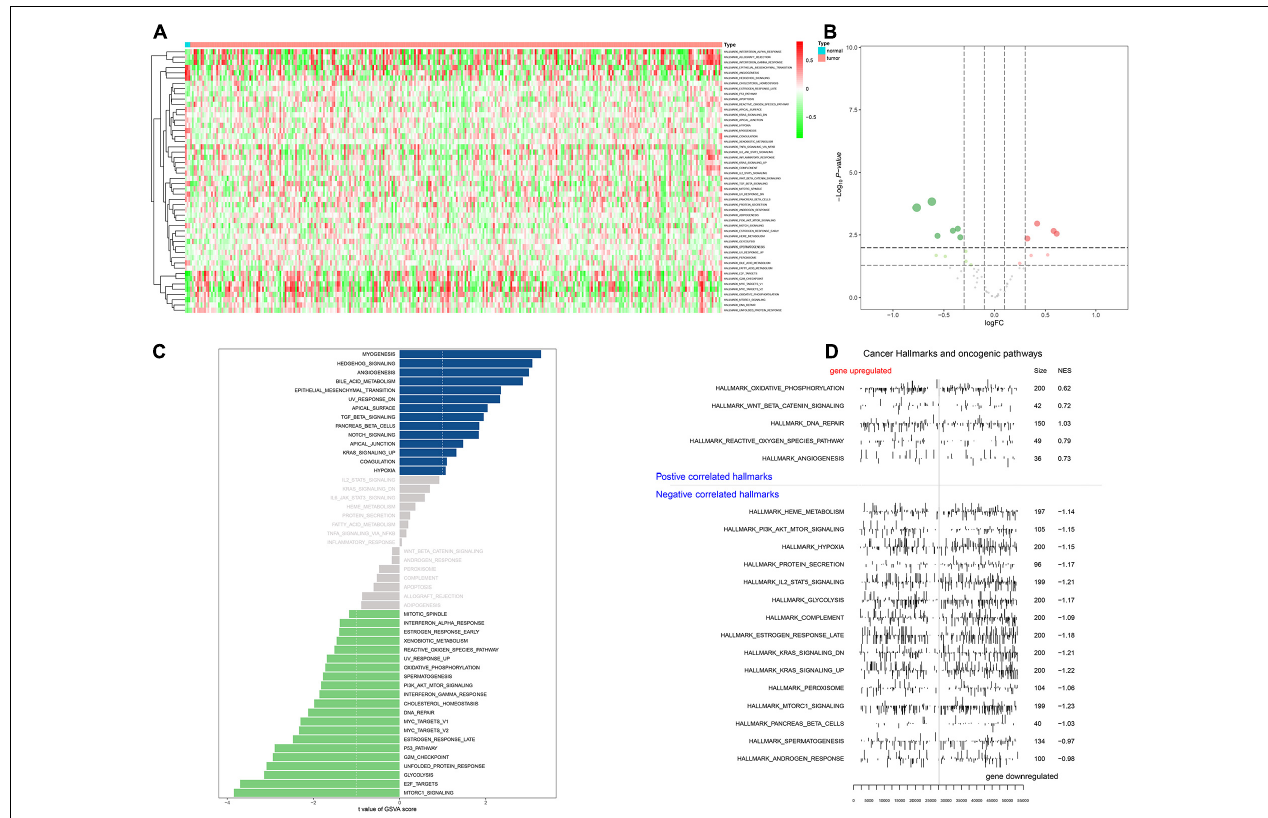
FIGURE 6 | Heat map for Gene set variation analysis (GSVA) showing the co-expression level of 50 hallmark gene sets in CESC samples (A) . Volcano plot for hallmark signaling pathways, green and red dots represented significant differential expression in PBMC samples (B) . Bar plot revealing the t value of GSVA score (C) . Positive correlated hallmarks and Negative correlated hallmarks acquired by GSEA (D)